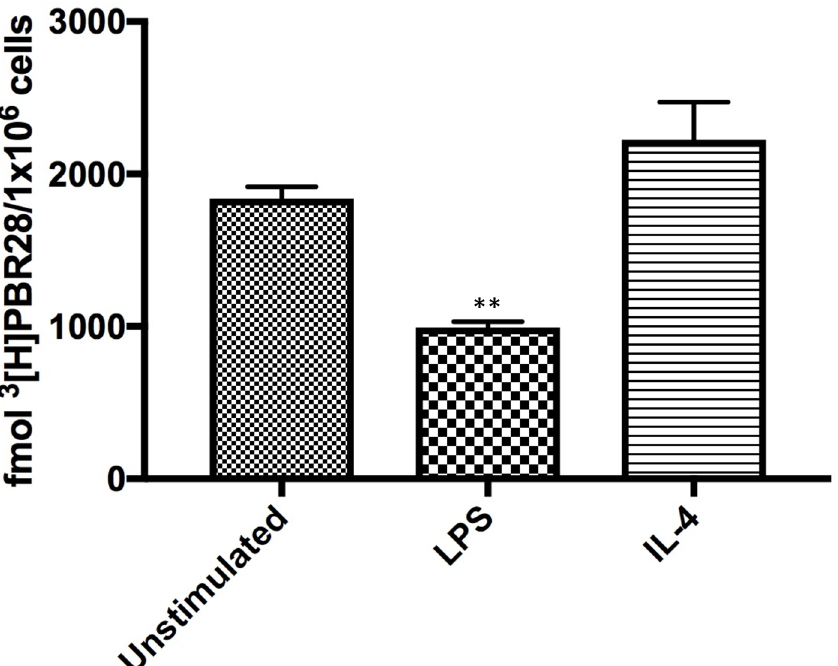
Fig 8. Binding of the TSPO specific radio-ligand [ 3 H]PBR28 in unstimulated, M1 and M2 healthy human peripheral blood MDM. Bindingof [ 3 H]PBR28 in unstimulated healthyperipheral blood MDM, in MDM stimulatedwith LPS plus IFN- γ , and MDM stimulatedwith IL-4 for 24 hours. Each experiment was performed in triplicate, with data expressedas mean ± SEM of five independent experiments. ** p < 0.01 comparedto